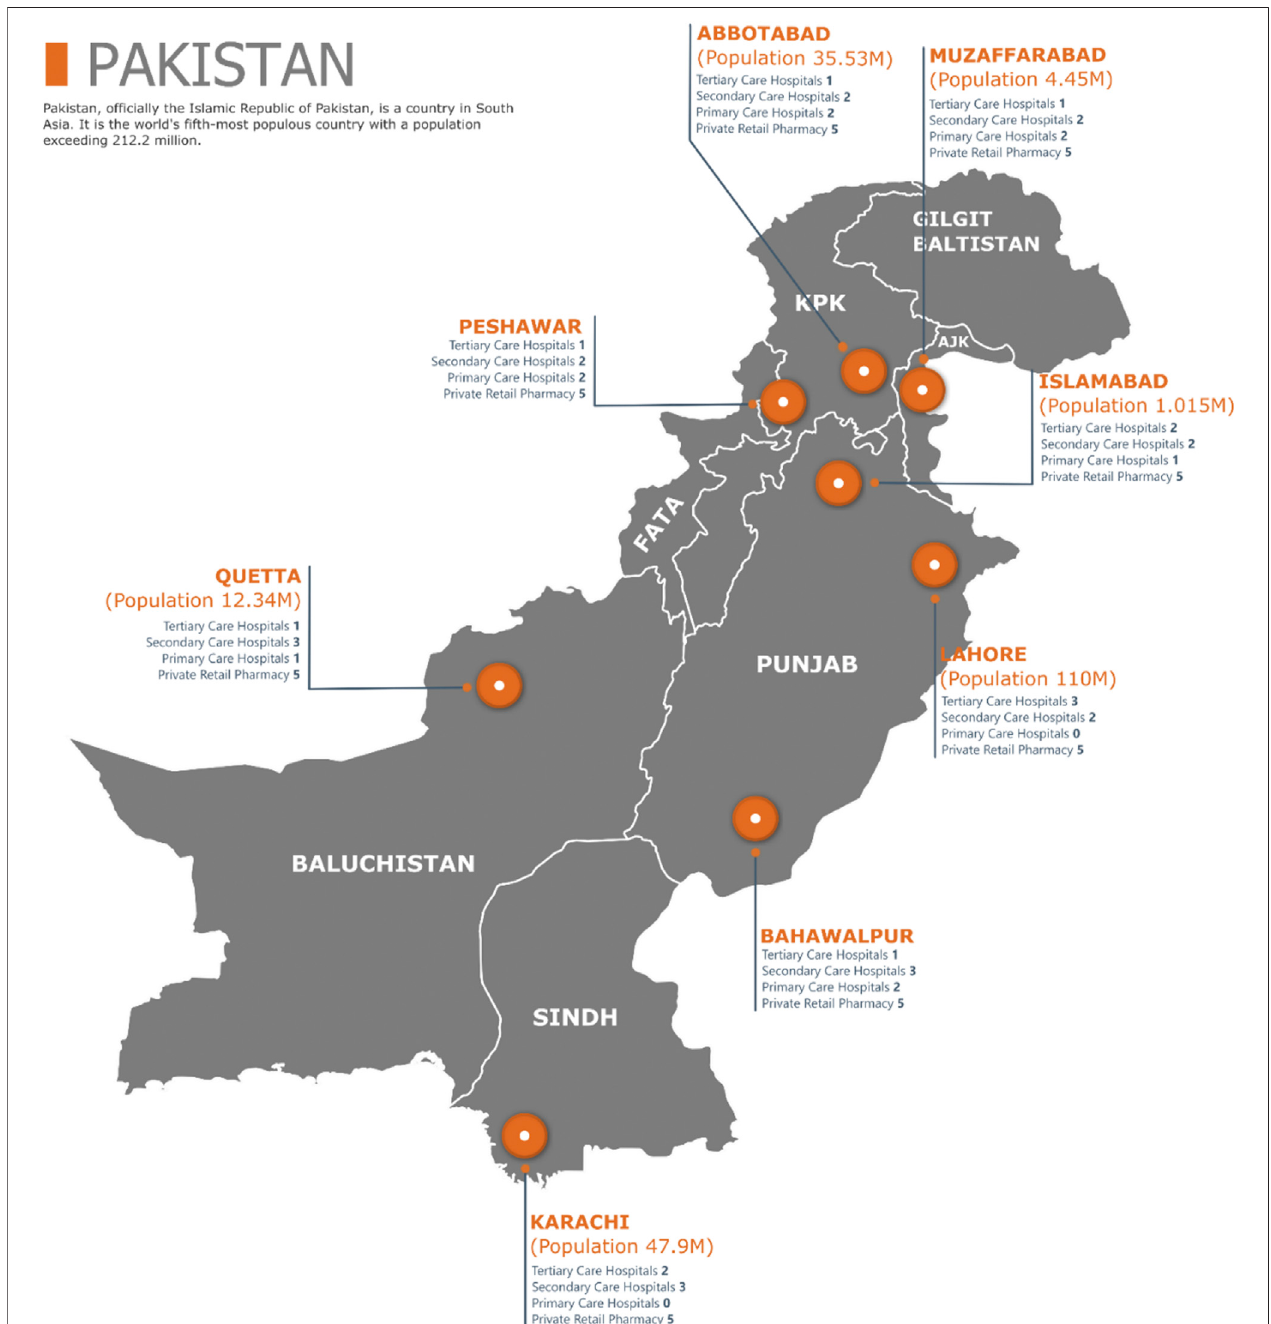
FIGURE 1 | Survey sampling regions in